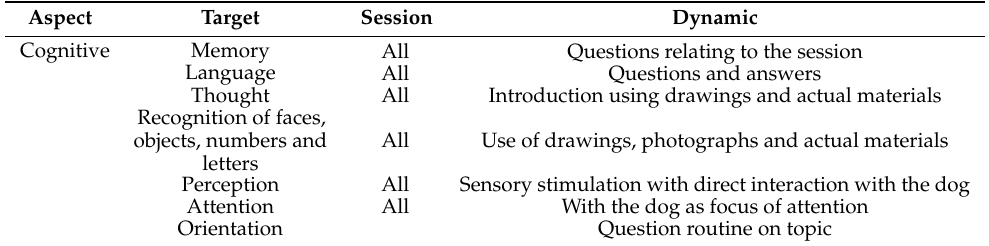
Table A1. Objectives of the DAT